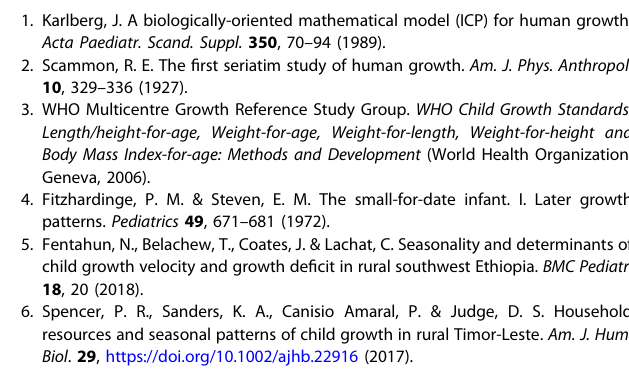
con fi dence intervals (CI). Data were also aggregated by combining data from the same months across the 4 years. We conducted multilevel linear regression analysis to evaluate the association between Δ LAZ/day and seasonality while controlling for correlations between repeated measurements of the same individual. To decrease the effect of systematic error due to repeated measurements, we allowed only one Δ LAZ/day per season for this analysis (Fig. 2). Mean Δ LAZ/day was calculated if there was more than one reference date in